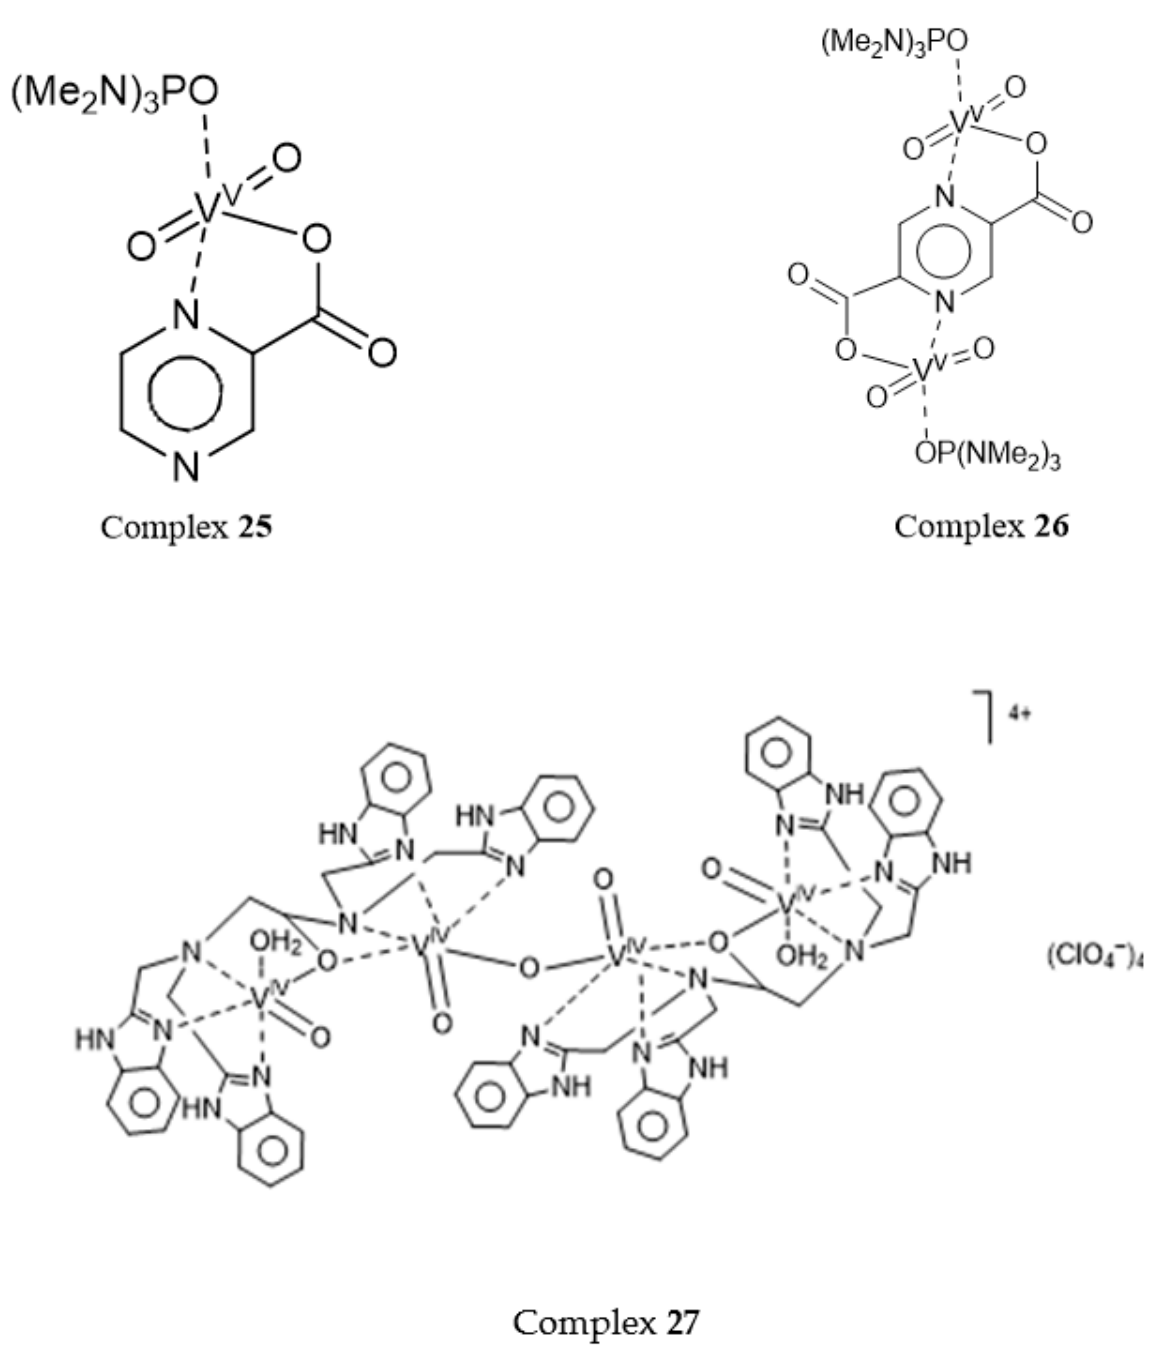
Figure 21. Structures of vanadium complexes 25 – 27 , Adapted from [156], Copyright (2009) with permission of Elsevier.